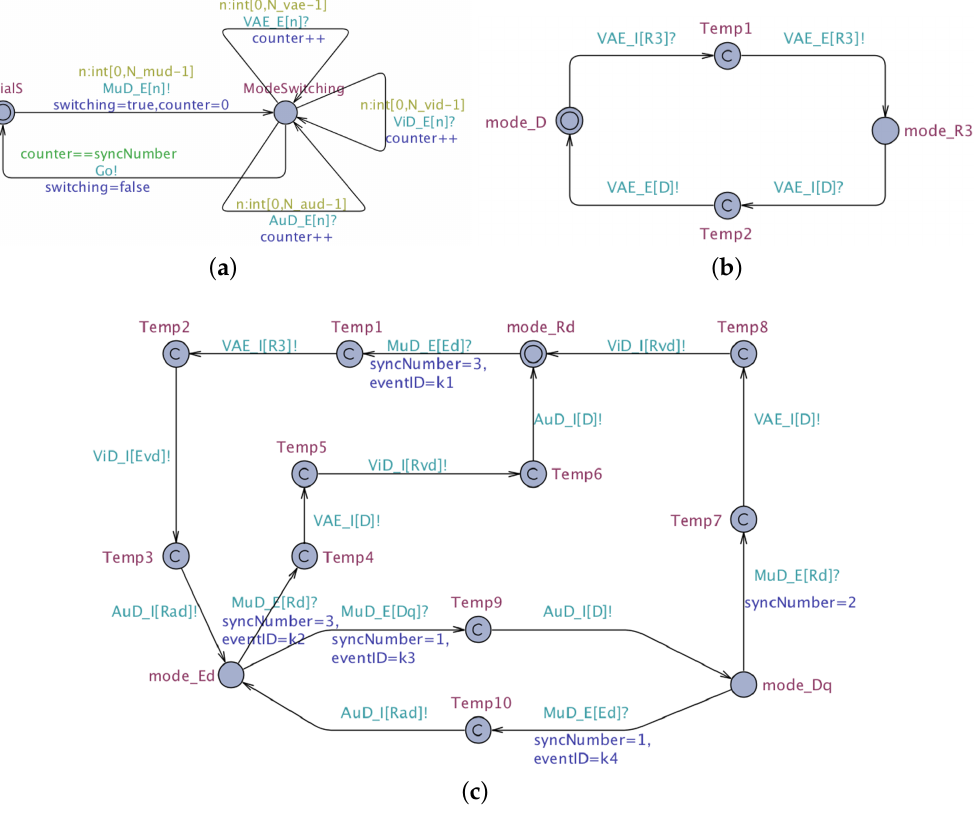
Figure 7. UPPAALmodels of the mode mapping of MuD. ( a ) UPPAAL model for the mode-switch manager of MuD. ( b ) UPPAAL model for the child MMA of VAE. ( c ) UPPAAL model for the self-MMA of